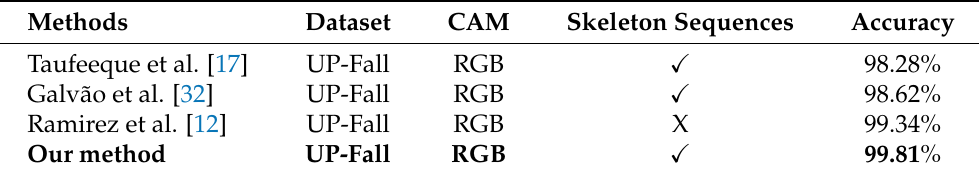
Table 4. Comparison with other methods using skeletons for fall detection with UP-Fall. Please note that (cid:88) —yes,